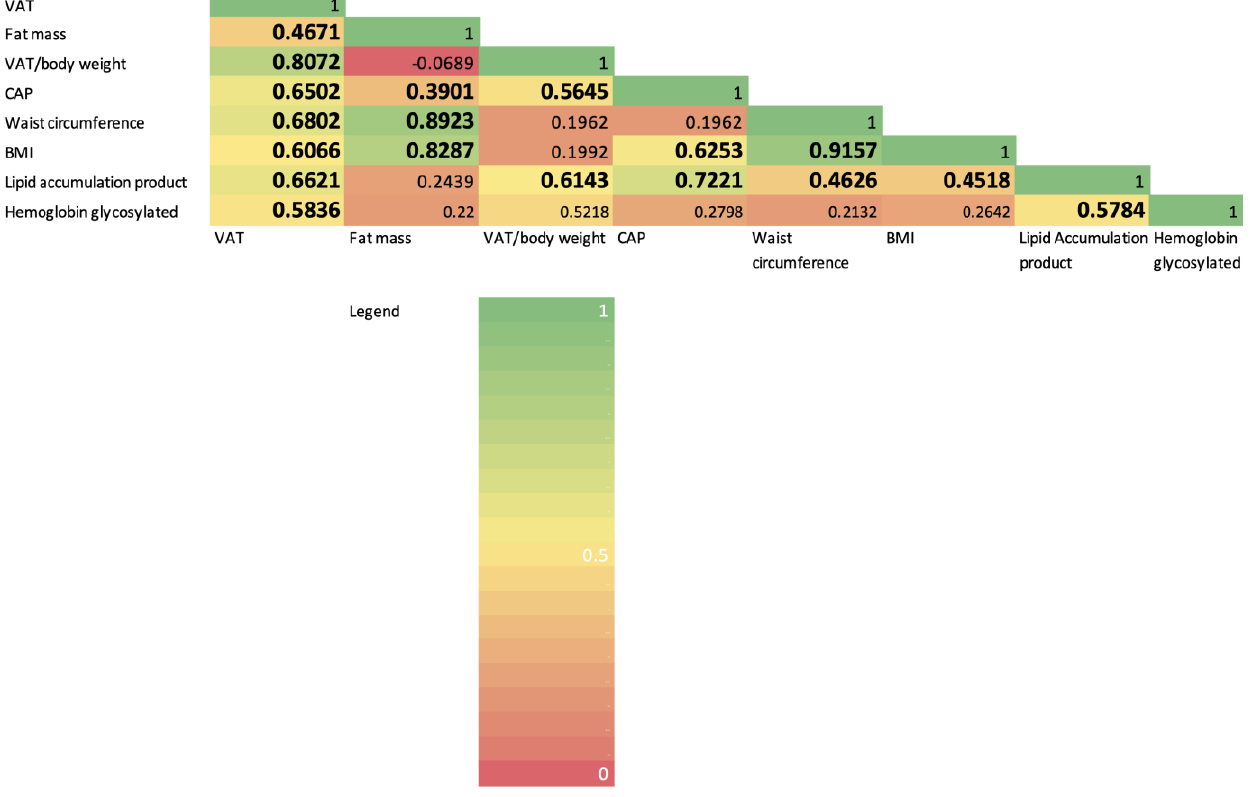
Figure 1. Correlation matrix with heatmap based on correlation coefficient analysis. Significant values ( p < 0.05) are bolded.